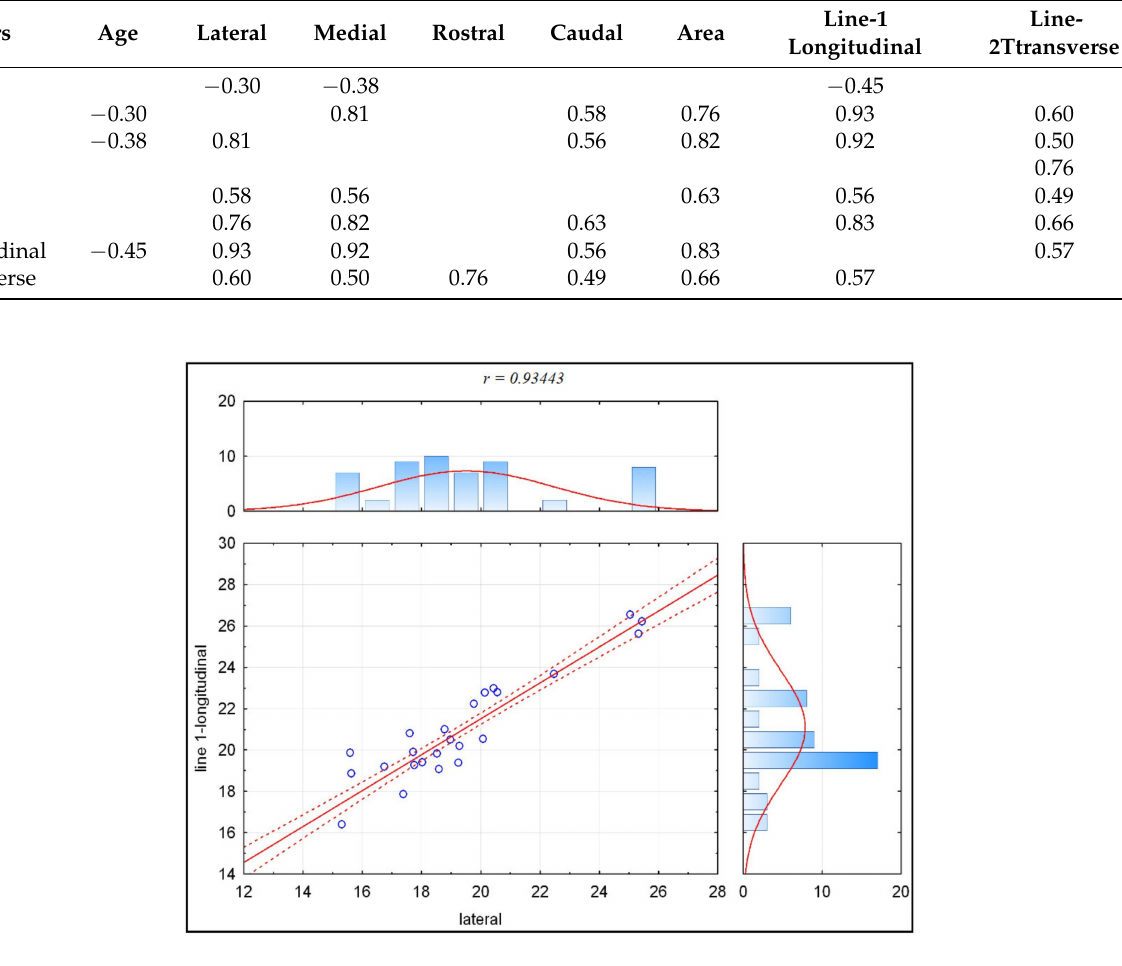
Figure 6. Correlation between the pairs of parameters (lateral and line-1 longitudinal) in male group.